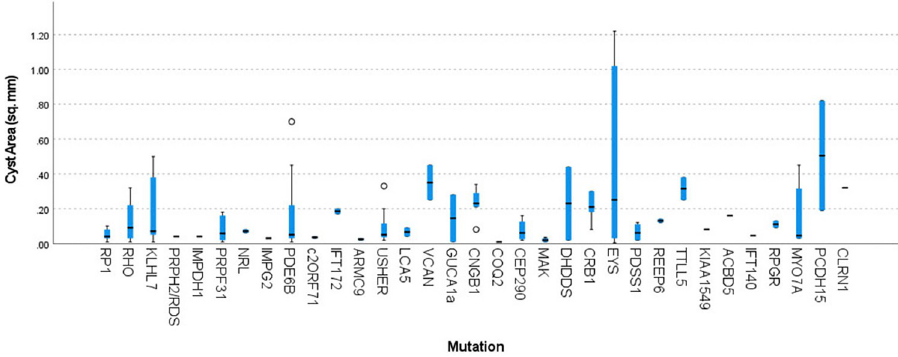
Fig 2. Distribution of intraretinal cyst sizes among underlying mutations causing retinitis pigmentosa. Comparison of cyst sizes in subjects with different underlying genetic mutations did not reveal any differences (p =